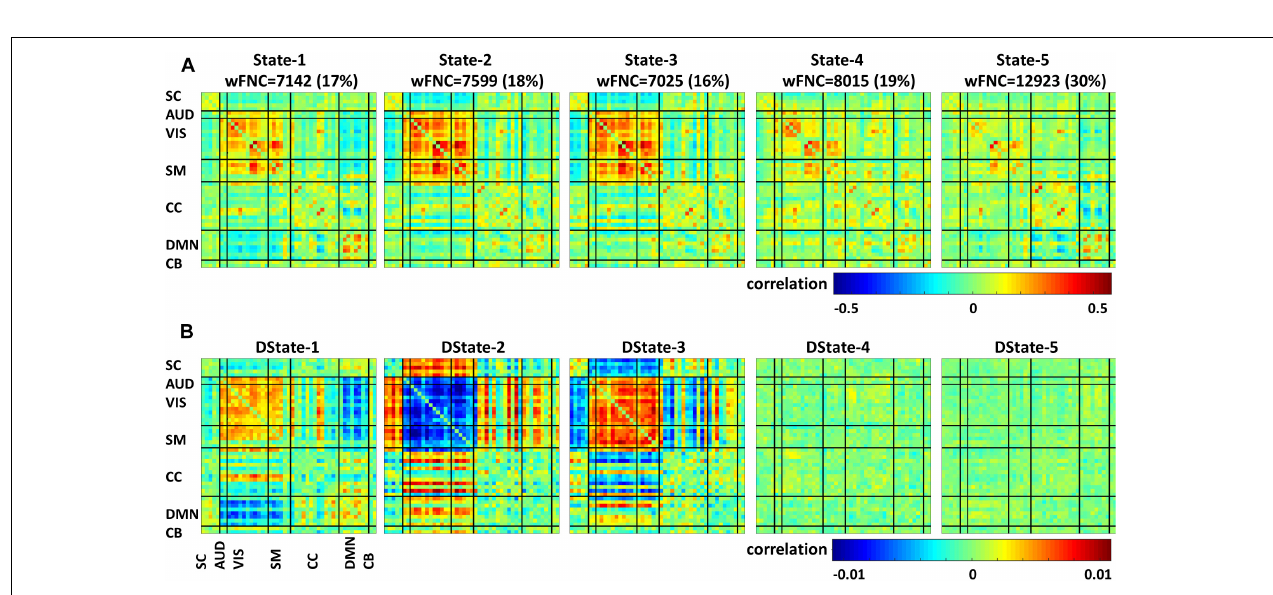
FIGURE 3 | Spatial Maps and their corresponding independent component numbers of the 47 selected resting state networks group into seven domains subcortical (SC), auditory (AUD), sensorimotor (SM), visual (VIS), default mode network (DMN), cerebellar (CB), and cognitive control (CC).